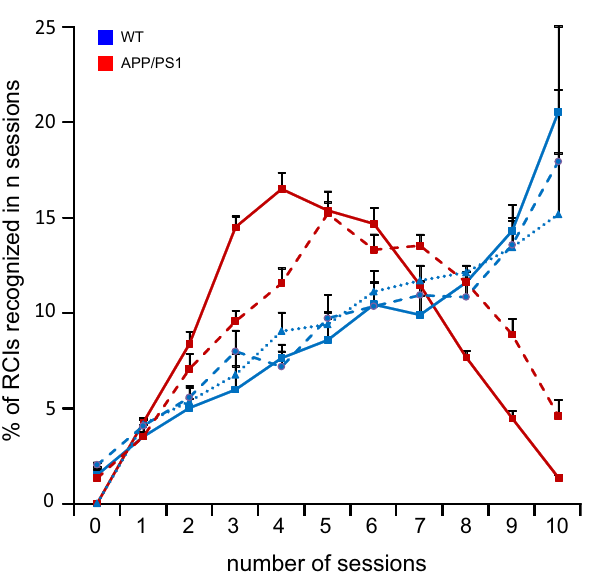
Figure 7. Distribution of recognized RCIs. The percentage of RCIs correctly recognized in a given number of sessions was plotted from 0 to 10 sessions in the WT (blue lines) and APP/PS1 group (red lines). Distributions in 3 experiments are indicated as follows: full frequency distribution of SWRs and full RCI content—solid lines, equalized distribution of SWRs’ frequency and full RCI content—dotted line, a full frequency distribution of SWRs and RCI without head and tail—dashed lines. Notice the remarkable difference in the distribution shape in the two groups: Whereas in the WT mice, the number of correctly recognized RCIs increases monotonically with the number of sessions considered (see solid, dotted, and dashed blue lines), in the APP/PS1 mice the distribution has a gaussian-like shape with a pronounced tendency for symmetry between the number of sessions with correct and in-correct